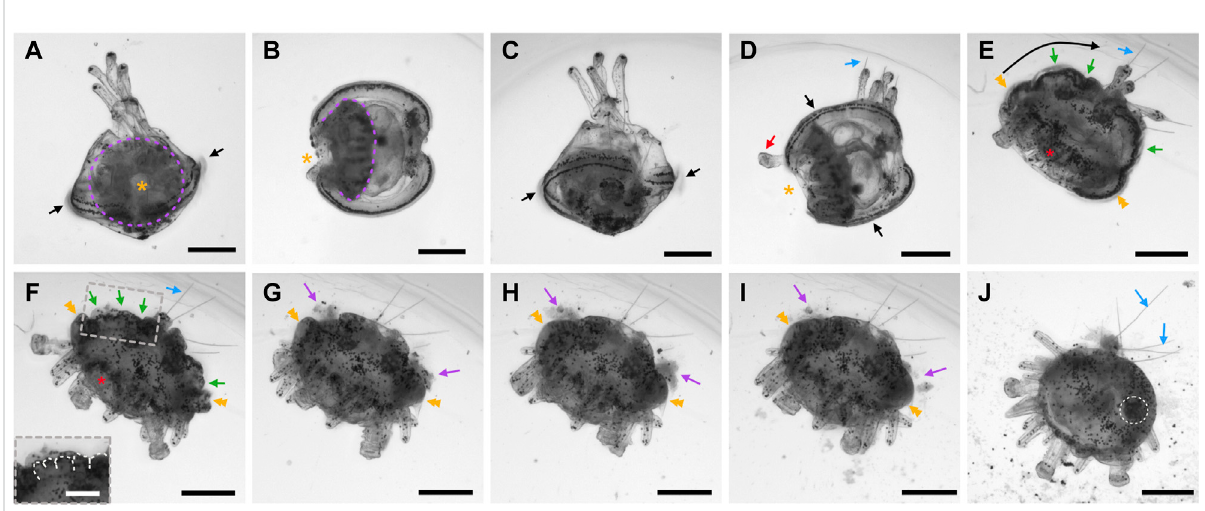
FIGURE 15 Thecompetentpluteusstageandmetamorphosisin Paracentrotuslividus .In (A – J) ,imageswereextractedfromamovierecordedusingbright- fi eld light microscopy. In (A) , the larva is in left view, with the ventral side up. In (B) , the larva is in dorsal view, with the rudiment on the left. In (C) , the larvaisinrightview,withtheventralsideup.In (D) ,thelarvaisindorsal,tiltedview,withtherudimentontheleft.In (E – J) ,thedevelopingjuvenileisin side view, with the oral surface towards the bottom left corner. ( (F) inset) Close-up of the folds at the level of the larval body epidermis. In (A,B) , purple dotted linesoutline theadultrudiment. In (A,B,D) , theorange asterisk highlights thevestibular pore.In (A,C,D) , blackarrowspoint to thelarval epaulettes. In (D) , the red arrow marks a protruding primary podium. In (D – F,J) , blue arrows highlight the larval arms and rods. In (E) , the long black arrow illustrates the movement of the larval body epidermis from the vestibular pore towards the larval arms and pedicellariae. In (E,F) , green arrows highlight folds of the larval body epidermis. In (E – I) , orange double arrowheads mark the bulge forming around the juvenile appendages by contraction and eversion of the vestibular lips and walls. In ( (F) inset), white dotted lines outline folds of the larval body epidermis. In (G – I) , purple arrows point to delaminating cells. In (J) , the white dotted line encircles a pedicellaria. Scale bar: (A – H) 200 μ m; ( (F) inset) 100